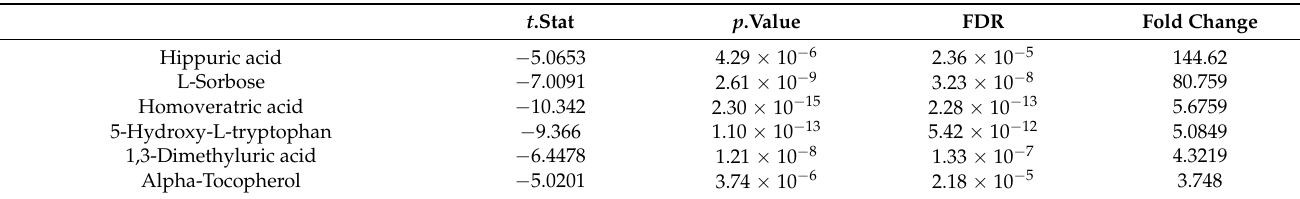
Table 2. Statically significant metabolites among the normoglycemic MetS and the controls. t